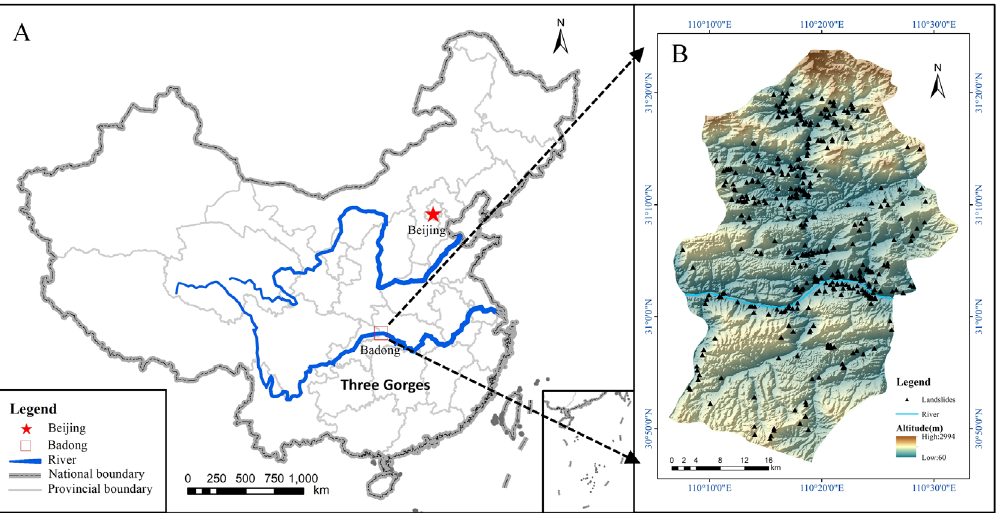
Figure 2. Location of the study area in China (( A ) map of China, ( B ) map of Badong County) .